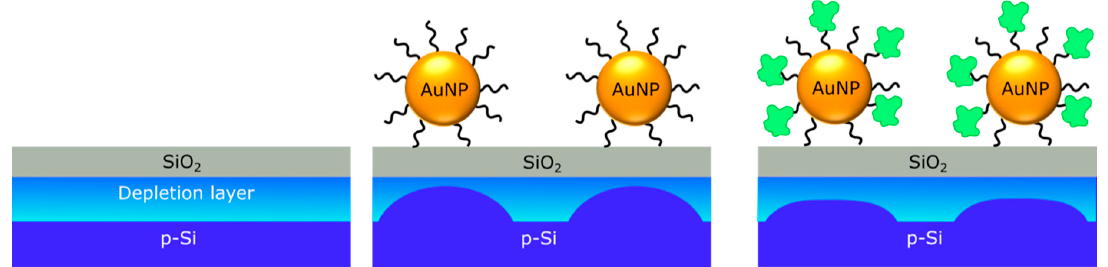
Figure 7. Schematic of a AuNP-modified capacitive EIS sensor. Expected modulation of the depletion layer after the deposition of negatively charged citrate-capped AuNPs and after the binding of positively charged molecules on AuNPs are exemplarily shown for a p-type EIS structure.